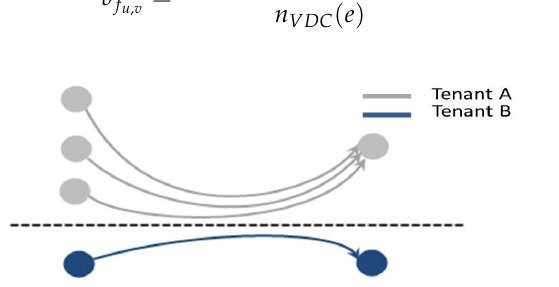
Figure 4. Fairness in the cloud based on tenants.